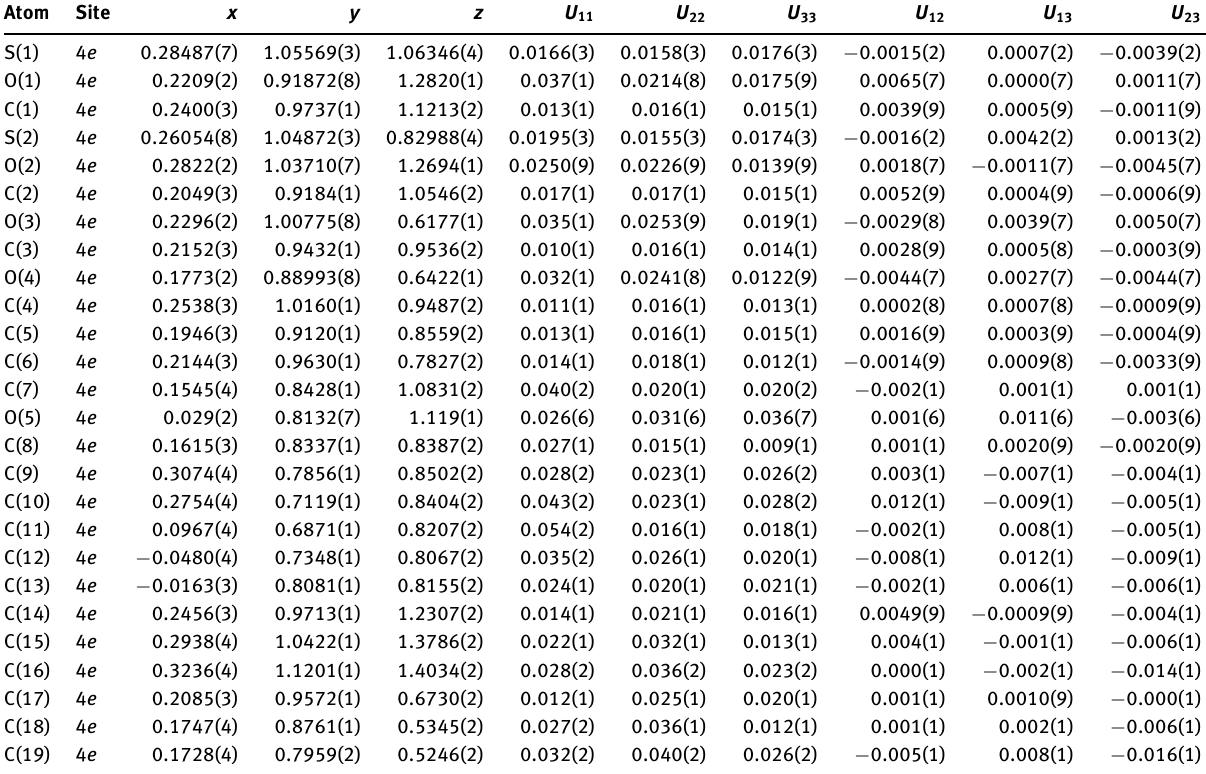
Table 3: Fractional atomic coordinate and displacement parameters (Å 2